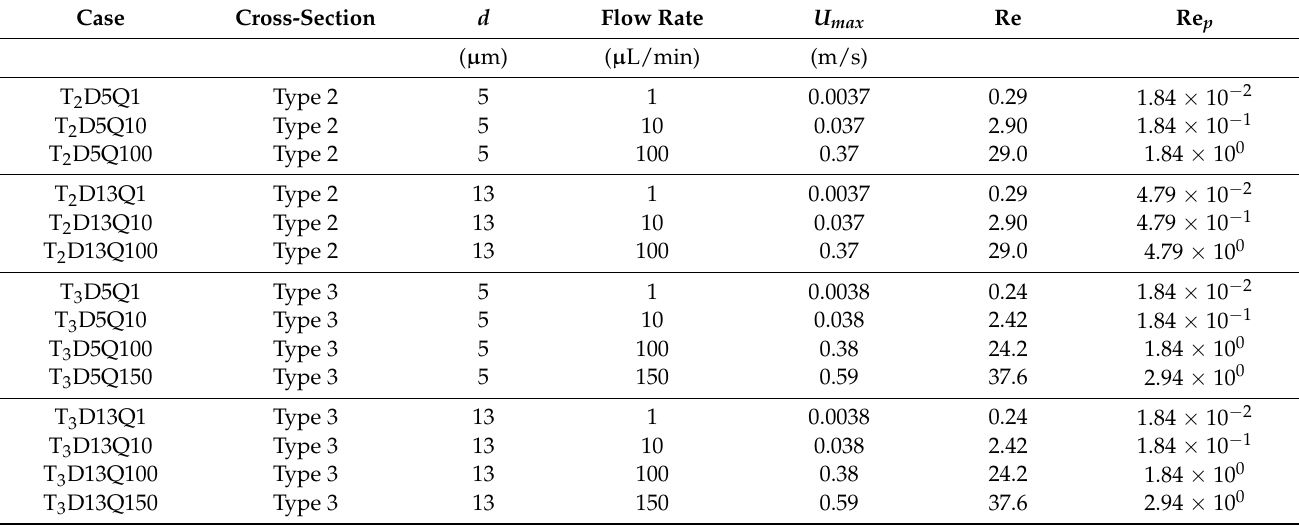
Table 2. Flow and particle parameters in the numerical